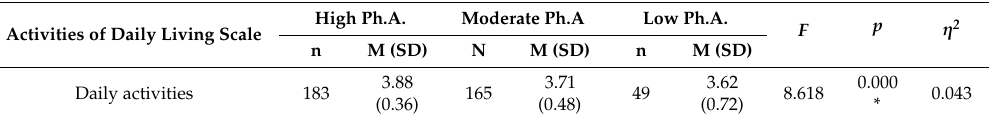
Table 4. Means, typical deviations and one-way ANOVA of the participant scores in the subscale of activities of daily living (CUBRECAVI) according to their level of physical activity. High Ph.A. Moderate Ph.A Low Activities of Daily Living Scale